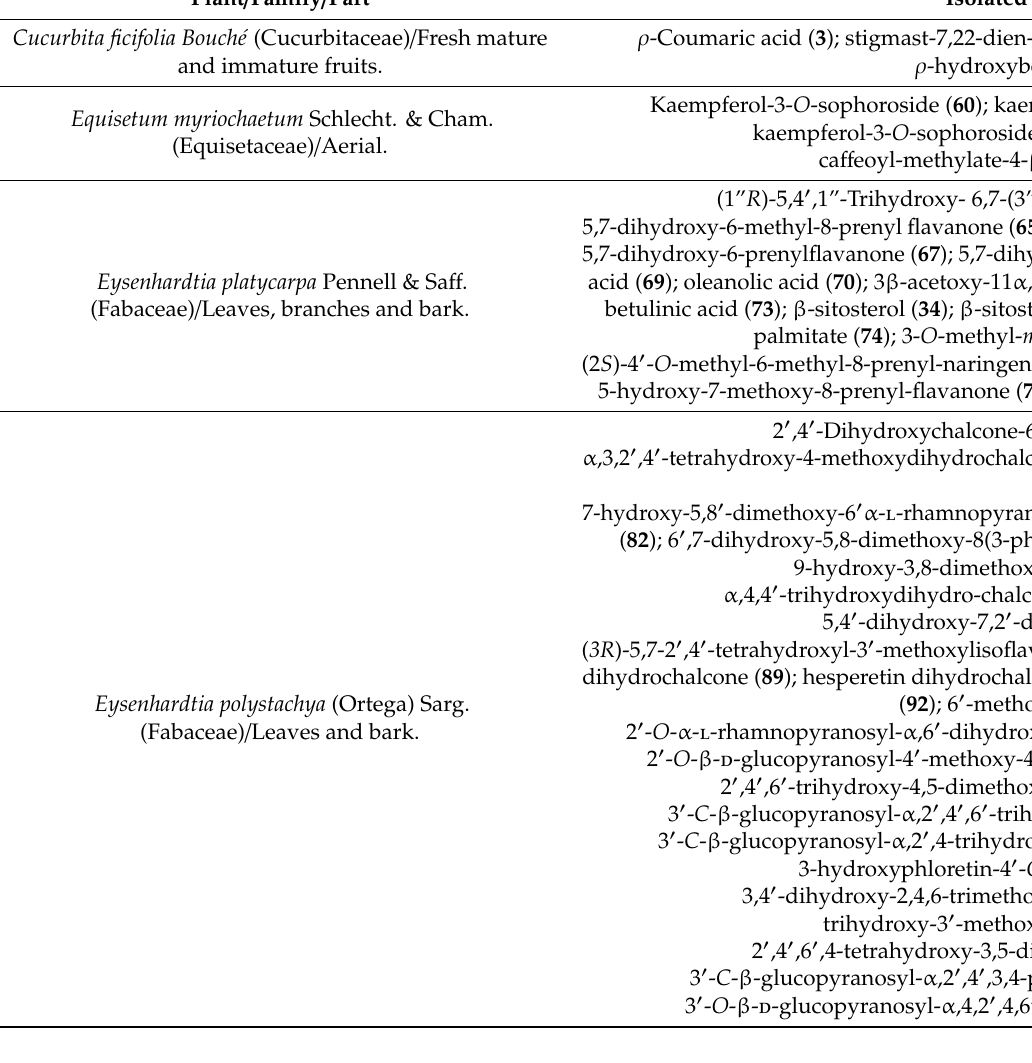
Plant / Family / Part Isolated Compounds Ref. Cucurbita ficifolia Bouch é (Cucurbitaceae) / Fresh mature and immature